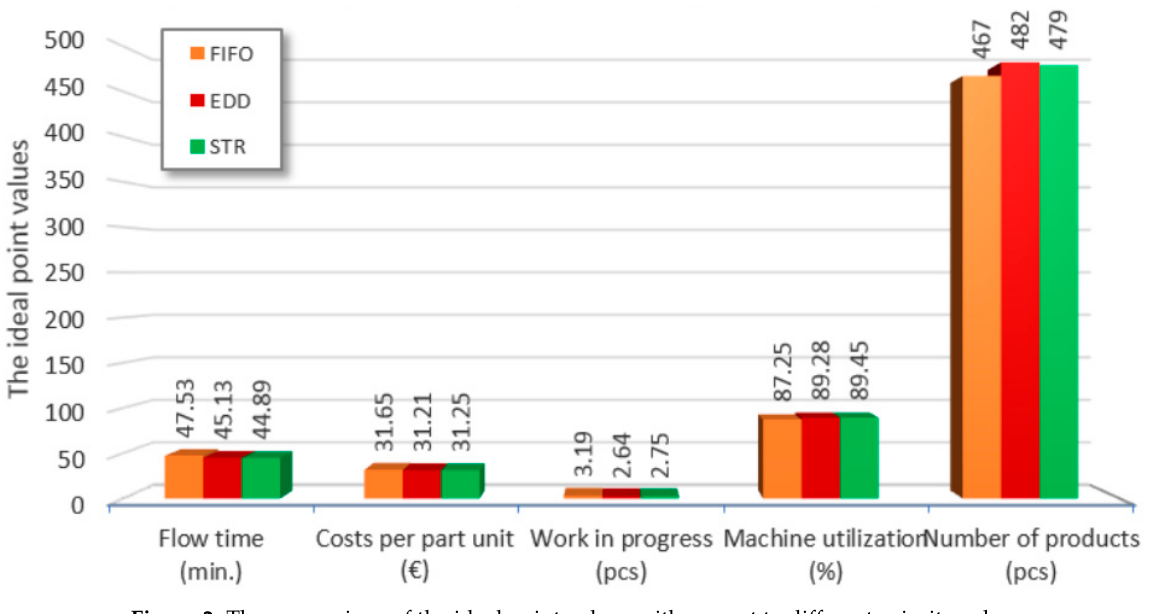
Figure 2. The comparison of the ideal point values with respect to different priority rules. Analogically, Figure 3 depicts a comparison of obtained values of the worst point. All data were presented in Table 6 above.